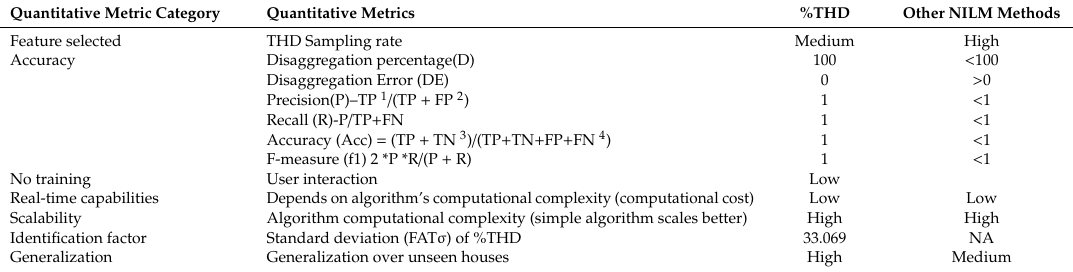
Table 4. Quantitative metrics for NILI–percentage